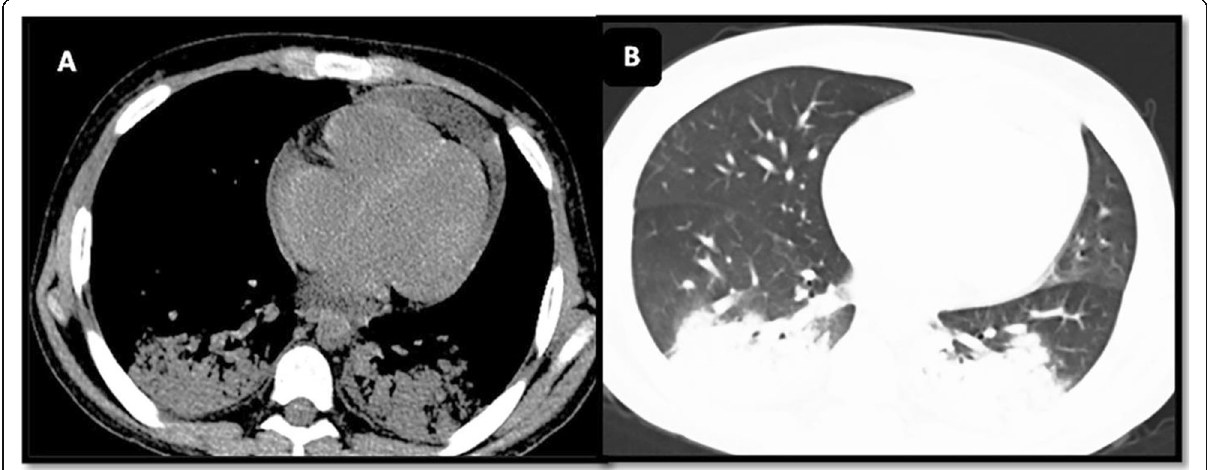
Fig. 6 A male patient aged 10 years old with ALL and under chemotherapy developed COVID-19 infection presenting with dyspnea, tachypnea, and fever (moderate clinical presentation). Chest CT revealed pericardial effusion and bilateral basal consolidative patches, with a severity score of 4 ( A , mediastinal window; B , lung